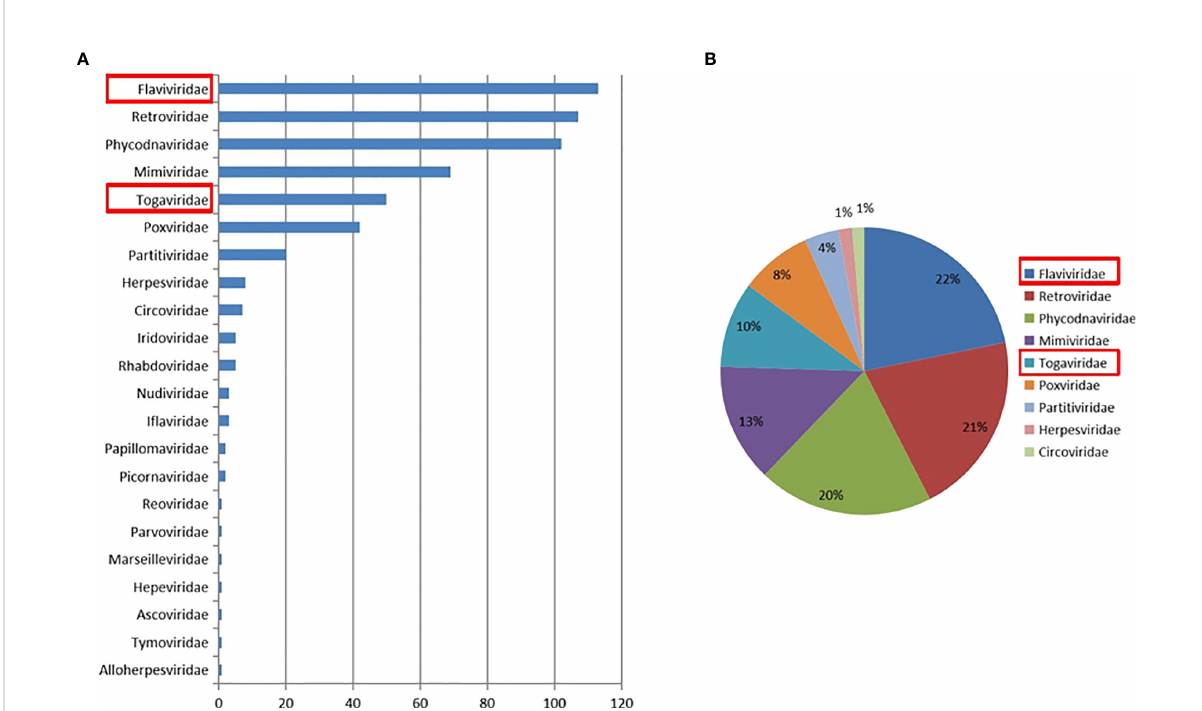
FIGURE 2 Abundance and proportion of viral families in Rhinolophus sinicus . The taxonomy of viral sequences according to viral family, with relative abundance (A) . The proportion of main viral families in Rhinolophus sinicus (B)